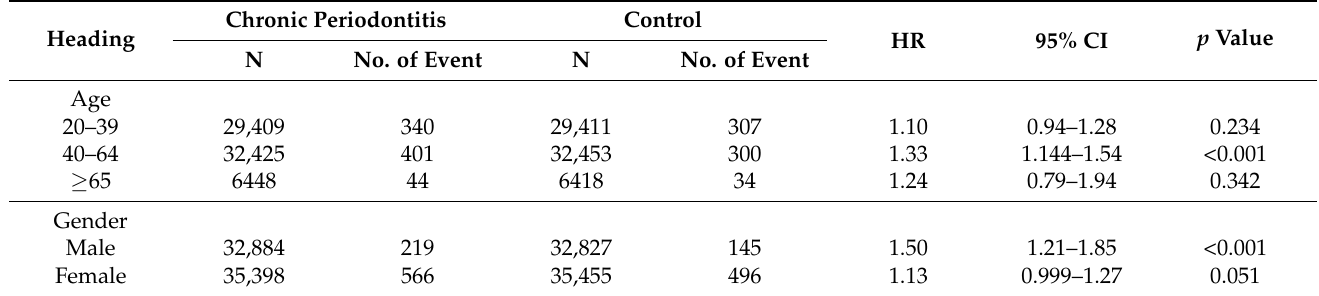
Table 4. Subgroup analysis of hazard ratios of chronic